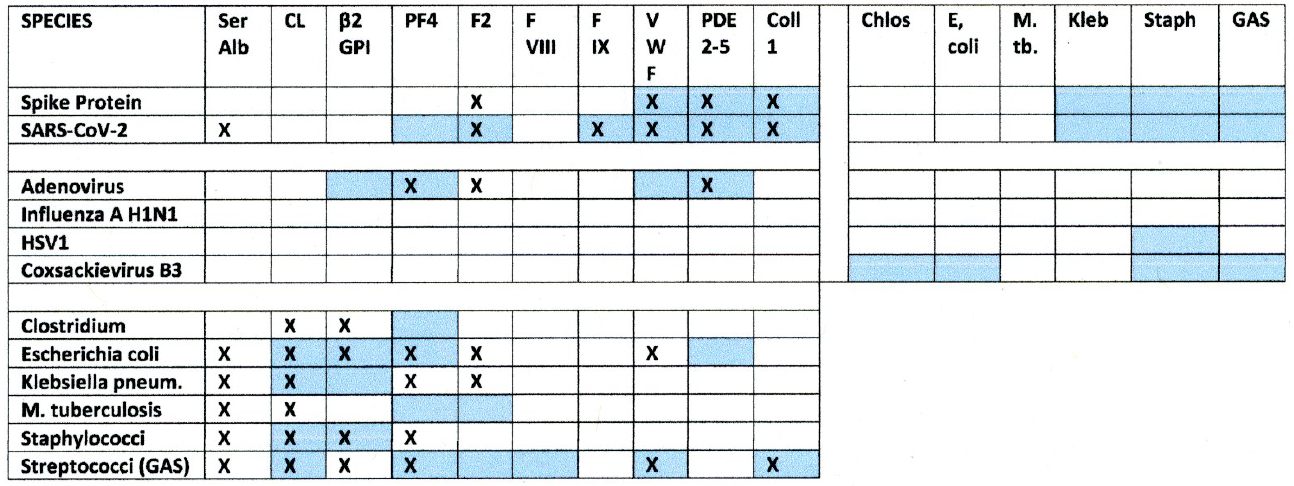
Figure 14. Summary of the Results. X’s represent similarities predicted by similarity searching summarized above in Figure 1 while the blue color represents experimentally significant binding reported in the Results section. Significance of antibody binding to proteins was determined as described in Table 3 as a function of the antibody affinity. No predictions have previously been made concerning the likelihood of an antibody induced by one microbe recognizing as antigenic an antibody raised against a different microbe, so there are no X’s in that portion of this Figure. Significant binding of one antibody to another was set at a Kd of 100 nM or less assuming that the concentration of any one antibody idiotype is unlikely to exceed 1 nM and therefore antibodies with less than a mutual binding constant of 100 nM are extremely unlikely to encounter each other in sufficient quantities to produce circulating immune complexes. CL = cardiolipin; Ser Alb = human serum albumin; β2GP = beta 2 glycoprotein; C1q, C3, C4 and C5 are complement proteins 1q, 3, 4 and 5; PDE = phosphodiesterase; F2, FVIII, FIX and FX are blood coagulatio n factors; VWF is von Willebrand’s factor; Coll 1 is collagen type 1. Bacterial abbreviations refer to the bacteria listed in the left-most column.